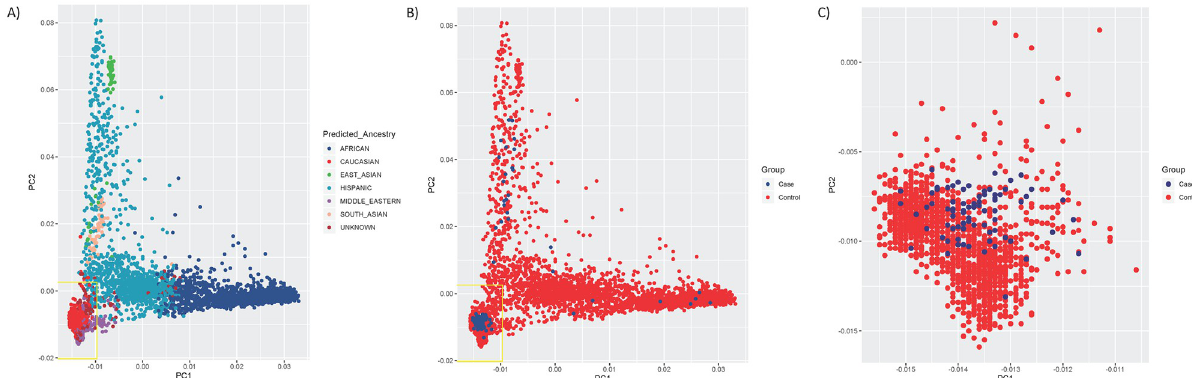
Fig 1. Scatterplot of Principal Component 1 (PC1) vs Principal Component 2 (PC2) from EIGENSTRAT ancestry analysis. (A) Scatter plot of PCs 1 & 2 prior to ancestry pruning, with subjects colored according to their predicted genetic ancestry. Yellow box indicates the region encompassing 6 s.d on PC1 and PC2. (B) Scatter plot of PCs 1 & 2 prior to ancestry pruning, with subjects colored by case/control status. Yellow box indicates the region encompassing 6 s.d on PC1 and PC2. (C) Scatter plot of PCs 1 & 2 after ancestry pruning and PCA outlier removal.